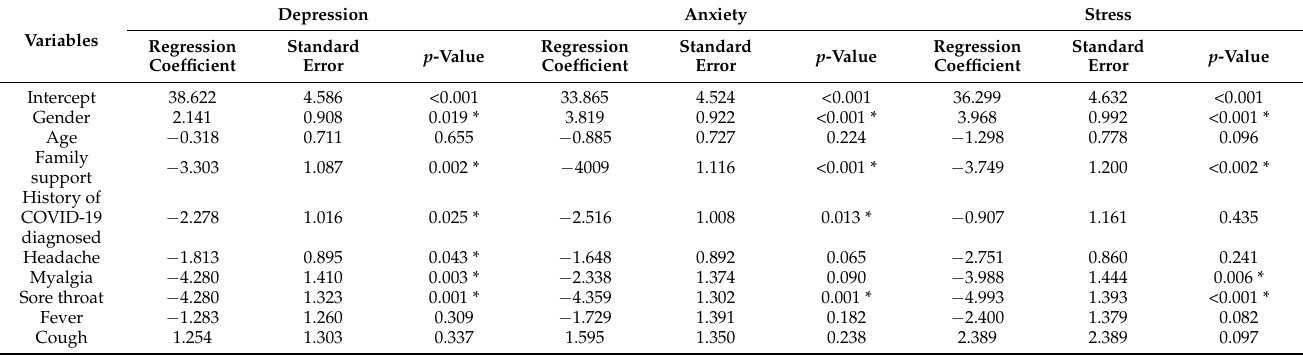
Table 7. Linear regression models for depression, anxiety, and stress.